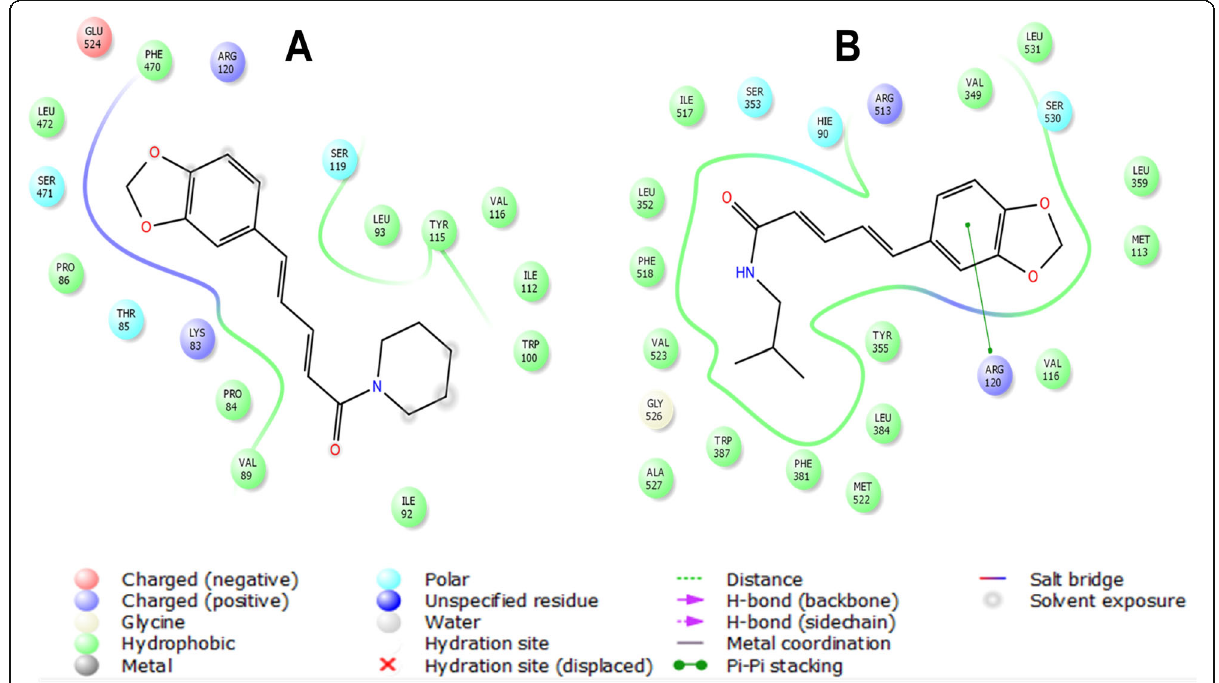
Fig. 2 Docking result of a (piperine) and b (piperlonguminine) with COX-2 (PDB: